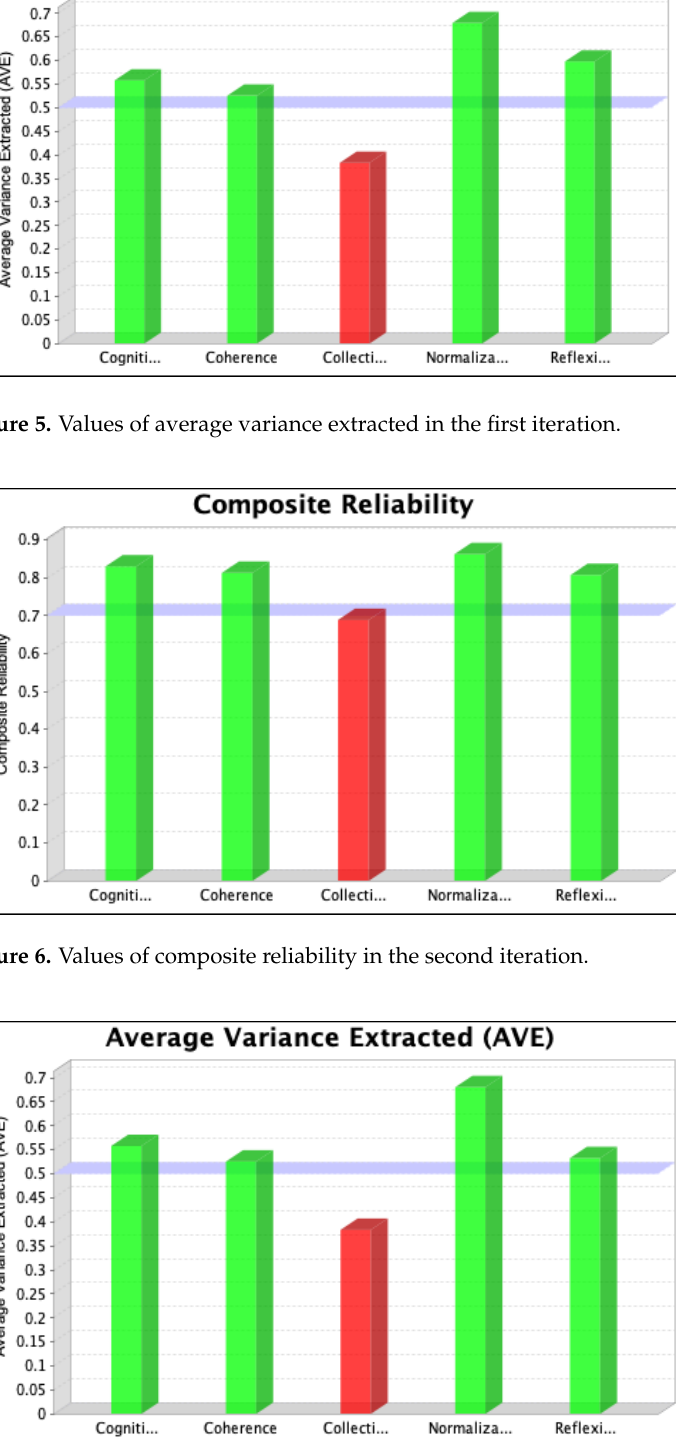
Figure 7. Values of average variance extracted in the second iteration. Table 1. Individual item validity and convergent validity.